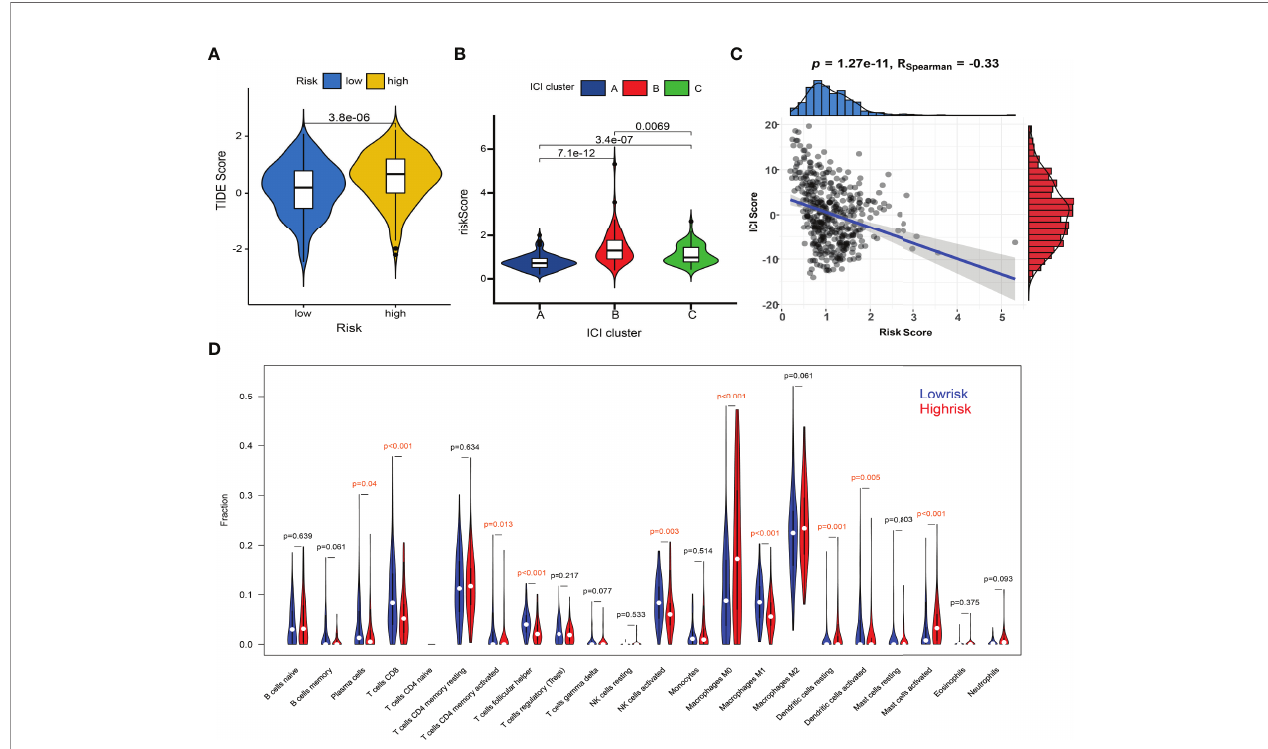
FIGURE 8 | Comparisons of TIDE scores and ICI levels in high-risk and low-risk patients. (A) Violin plot of TIDE scores in high- and low-risk groups. (B) Risk scores among different immunotypes. (C) Spearman correlation between the risk scores and TIDE scores. (D) Violin plot of ICI